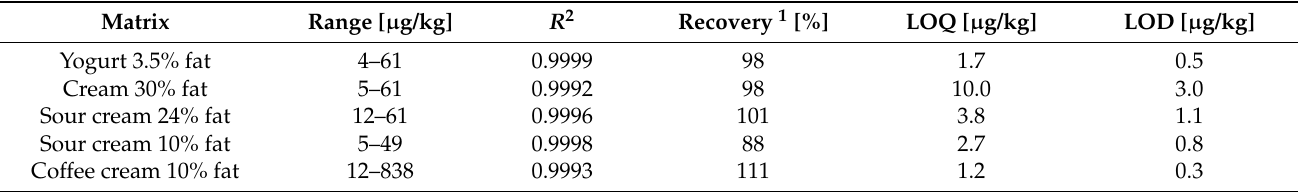
Table 3. Main parameters of the calibration curves for styrene, limits of quantification (LOQ) and detection (LOD) in the investigated food